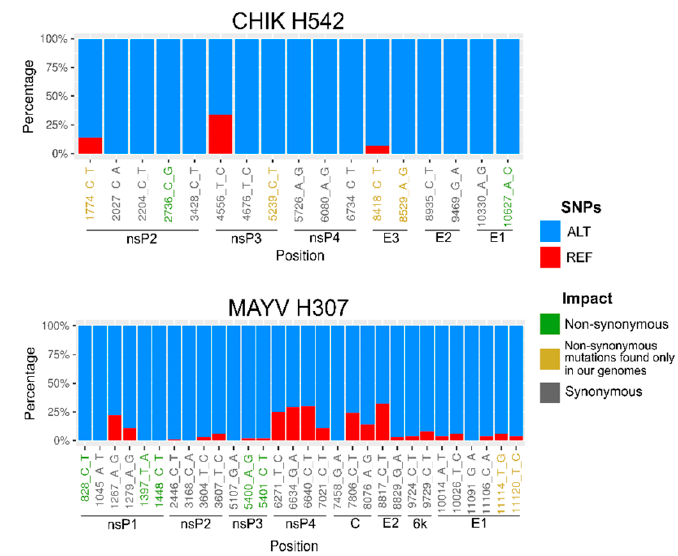
Figure 4. Single nucleotide polymorphism (SNP) analysis. Proportion of sequencing reads supporting the reference nucleotide (REF—red) and the SNPs (ALT—blue) from the CHIKV and MAYV genomes obtained in this study. Green, yellow and gray position names below each bar plot denote non-synonymous, non-synonymous mutations found only in our genomes and synonymous SNPs.